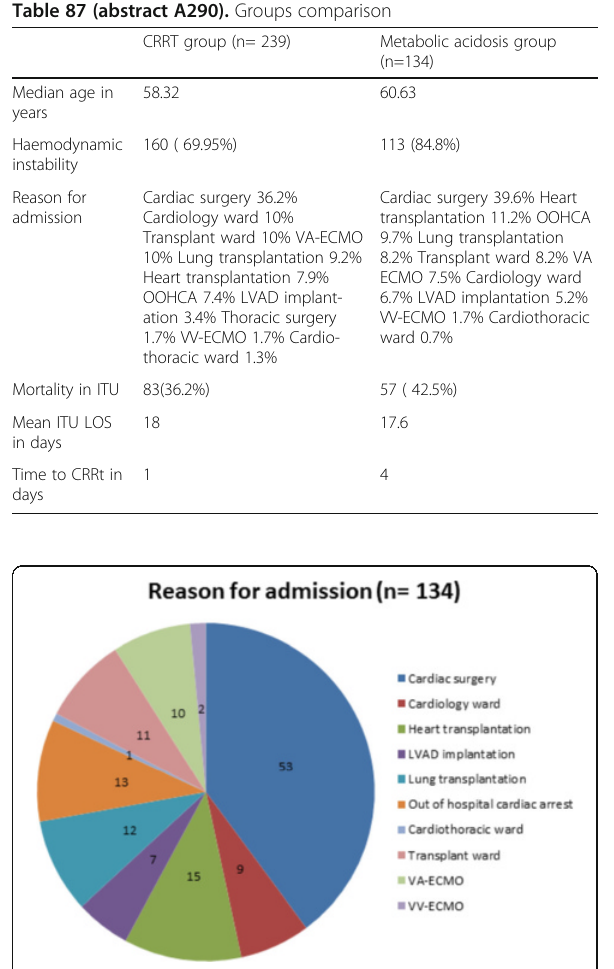
Fig. 113 (abstract A290). Reason for admission to